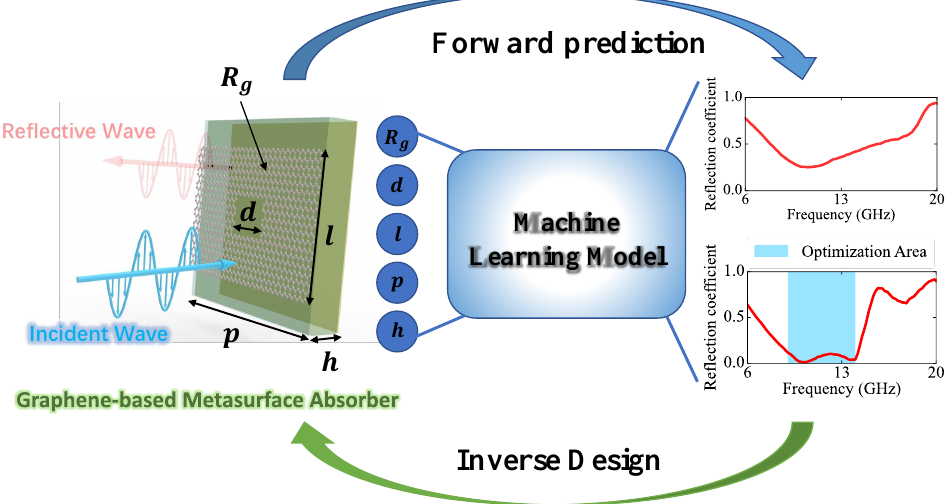
Figure 1. Schematic diagram of forward prediction and inverse design of graphene-based microwave absorbers using machine-learning